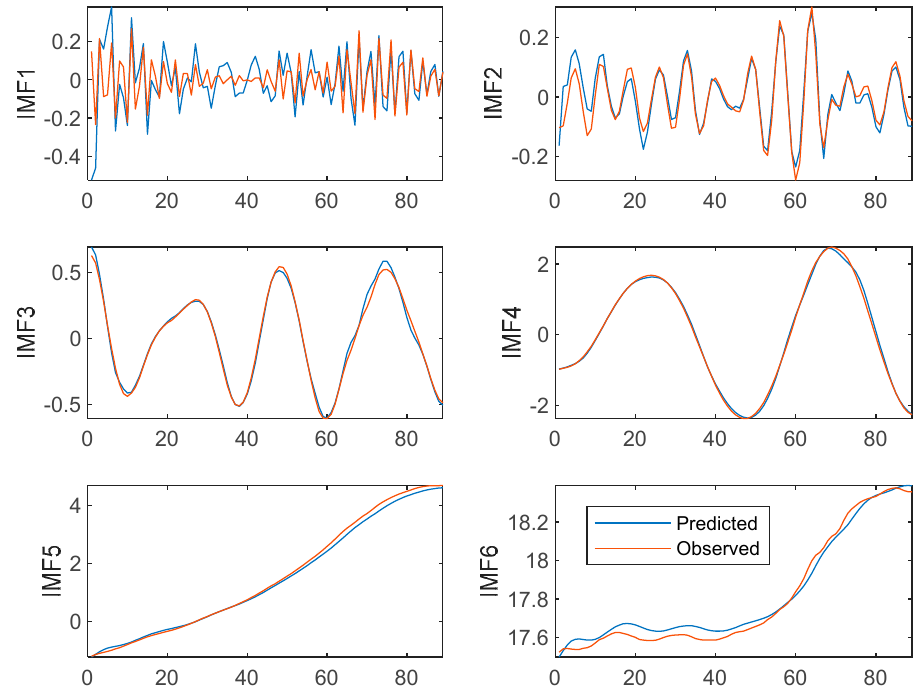
Figure 7. Fitting results of IMF components of crucian carp price dataset.